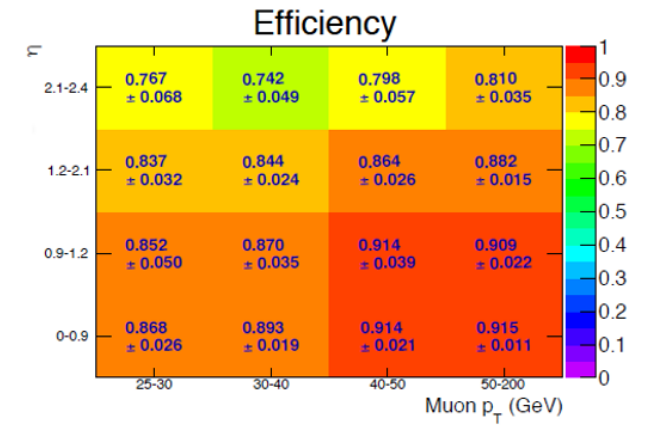
Figure 1. Example of muon e ffi ciencies from a SUSY analysis as a function of the momentum ( p T ) and the pseudorapidity ( η